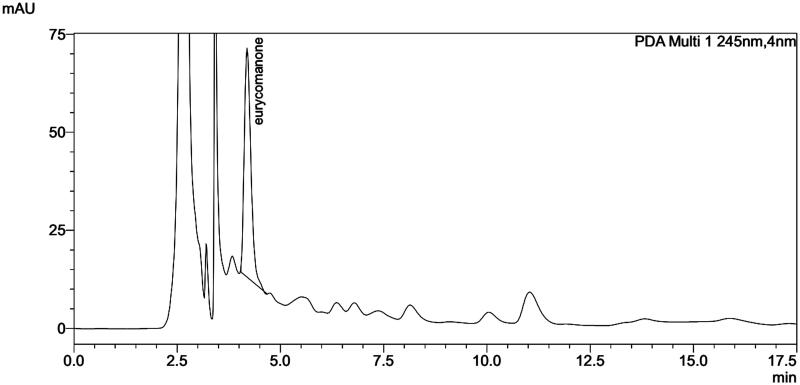
HPLC chromatogram of eurycomanone extract from E. longifolia rhizome.